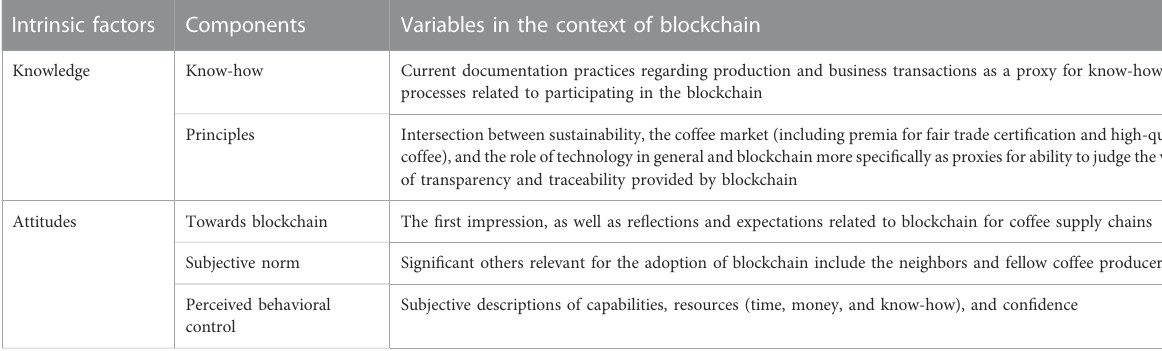
TABLE 2 Variables that proxy intrinsic factors in the context of blockchain adoption. Intrinsic